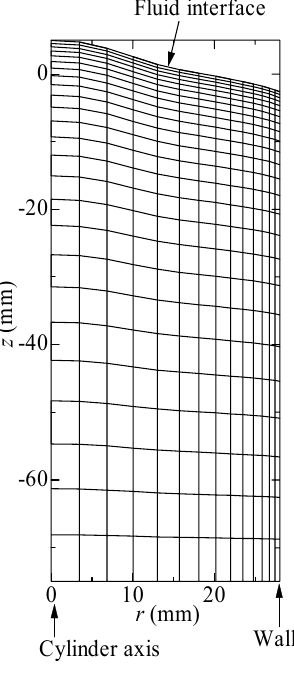
Fig. 7 Typical mesh point distribution in the calculational